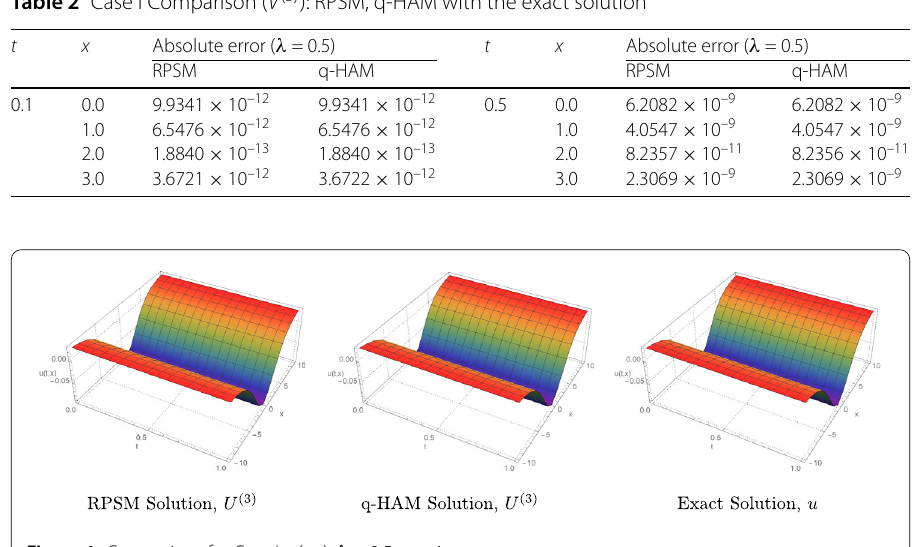
Figure 1 Comparison for Case I: u ( t , x ), λ = 0.5, α = 1